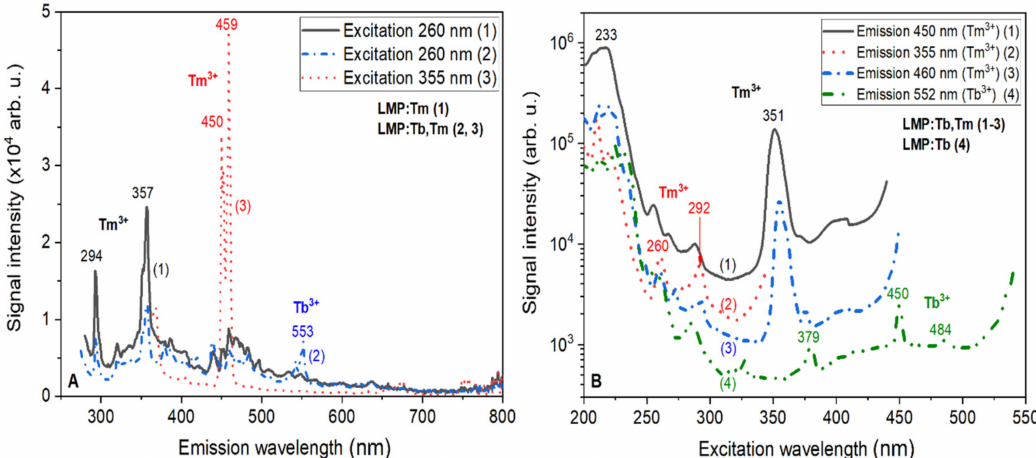
Figure 7. Emission ( A ) and excitation ( B ) spectra measured for LiMgPO 4 :Tm and LiMgPO 4 :Tb,Tm crystals investigated within this work. The emission spectra shown in ( A ) were registered under excitation in the respective excitation bands of Tm 3 + ions visible in ( B ). The excitation spectra shown on ( B ) were registered in the emission maxima corresponding to the luminescence of Tm 3 + ions (355 nm and 450–460 nm) and Tb 3 + ions (550 nm).